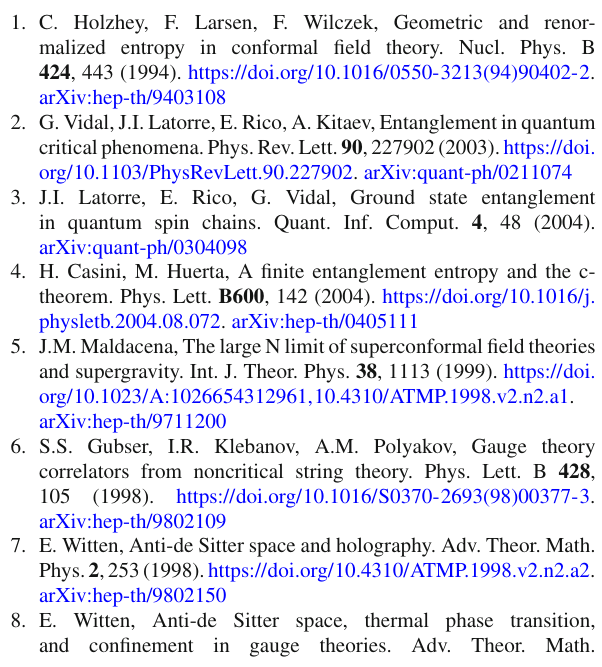
account the covariant formulation instead of the RT